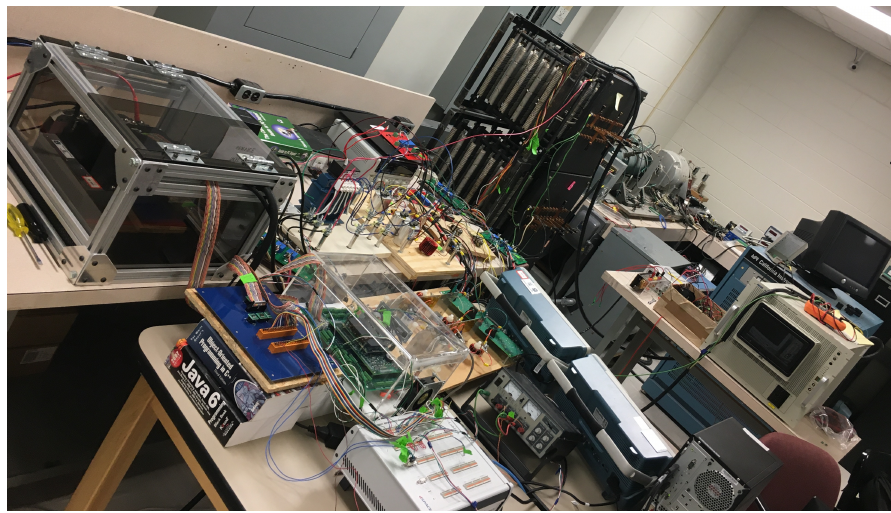
Figure 12. Hardware testbed system. Two different experiments were performed: balanced grid inductance with values of 4.2 mH on each phase. These inductances were realized by connecting three inductors in series (1.7 mH, 1.52 mH, and 1 mH) as shown in Figure 13. For the second experiment, unbalanced grid inductors were constructed using different inductance values: 3 mH, 4.5 mH, and 5.1 mH. Three inductors were connected in series to obtain these